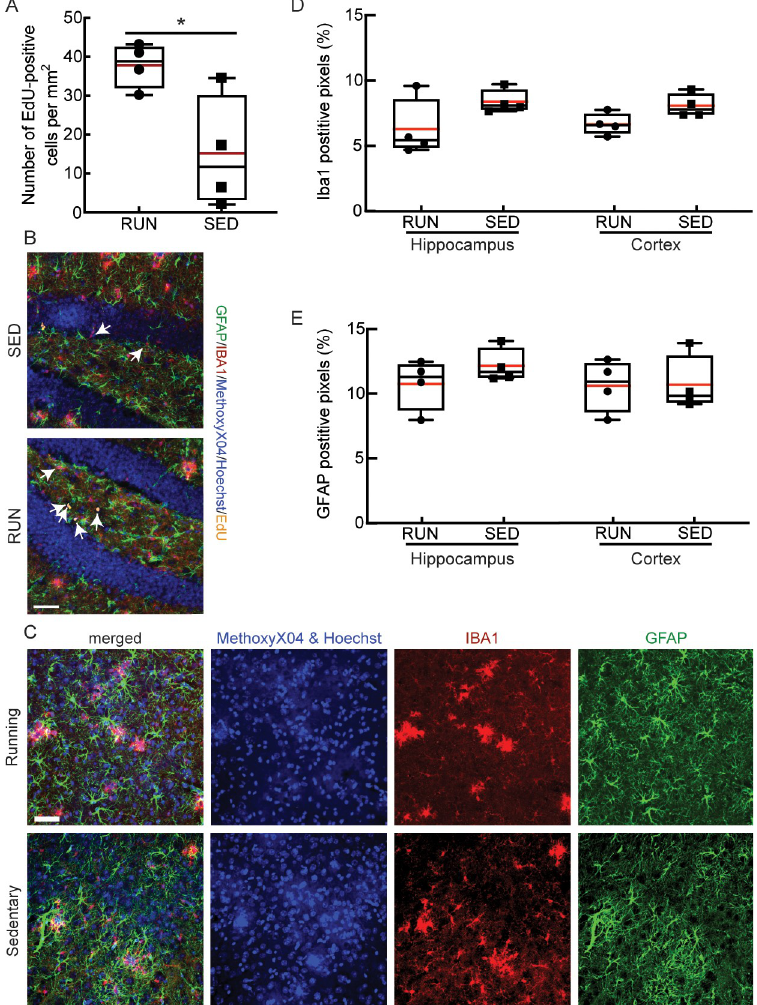
Fig 3. Running increased neural stem cell proliferation in the dentate gyrus, but did not decrease inflammation. A Boxplot of the density of EdU positive cells in the dentate gyrus from running (RUN) and sedentary (SED) APP/PS1 mice (P = 0.03, Mann-Whitney test). B Representative confocal images of tissue sections from the hippocampus of sedentary (top) and running (bottom) APP/PS1 mice, with labeling of astrocytes (anti-GFAP, green), microglia (anti- Iba1, red), amyloid plaques (Methoxy-X04, blue; no amyloid plaques visible in these fields), cell nuclei (Hoechst, blue), and proliferating cells (EdU, yellow, indicated with arrows). C Representative confocal images of tissue sections from the cortex from running (top) and sedentary (bottom) mice. Labeling is the same as in panel B. Images to the right show individual channels. D Microglial density, represented as the fractional area that is Iba-1 positive; E Astrocyte density, represented as the fractional area that was GFAP positive; from the hippocampus and cortex of RUN and SED APP/PS1 mice. Animal numbers: RUN: n = 4; SED: n = 4. Scale bars indicates 50 μ m. could detect changes in the incidence of stalled capillaries of 0.3% or larger. We further quanti- fied red blood cell flow speed and vessel diameter in cortical capillaries (Fig 6C), and saw no differences, on average, between running and sedentary APP/PS1 mice (Fig 6D). Again, there was no statistically significant difference in average capillary flow speed or diameter between individual animals in each group. Post-hoc sensitivity analysis (G � Power; Student t-test, α = 0.05, β = 0.80) with the realized variance of the measurement and the mean speeds from the running and sedentary groups suggested we could detect a 30% change in flow speed. Capillary